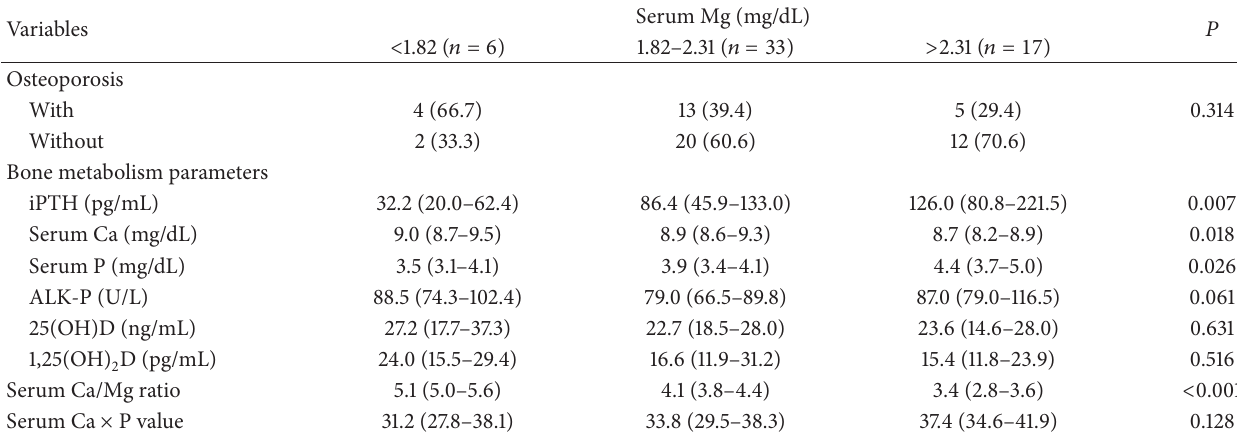
Table 3: Correlation of different serum Mg levels with osteoporosis and bone metabolism